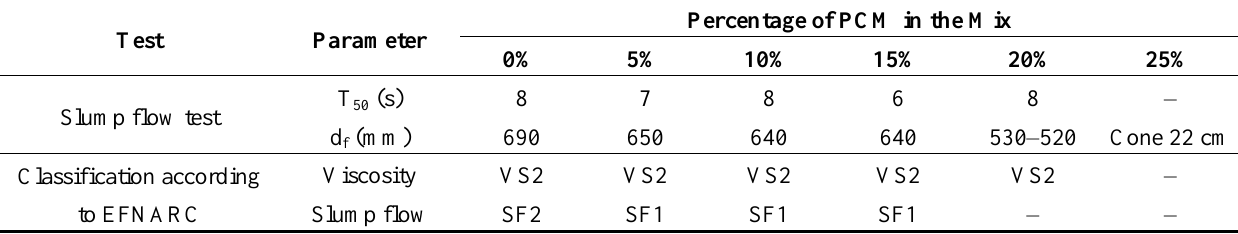
Table 3. Slump flow test results and self-compacting concrete (SCC) classification according to Annex A of the